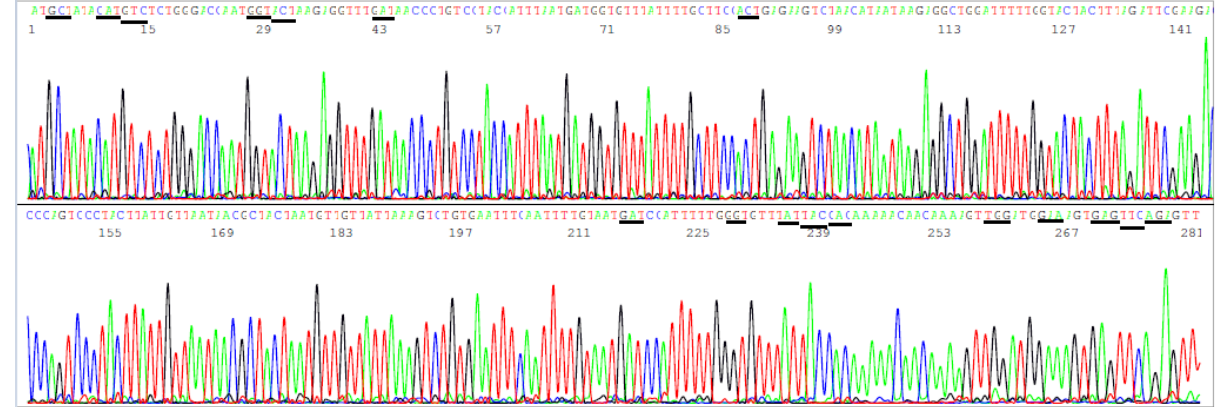
Figure 6. This is a figure of computer-generated electropherogram showing 17 codons (underlined) of S protein amino acids in the NTD region commonly used to help distinguish SARS-CoV-2 variants.